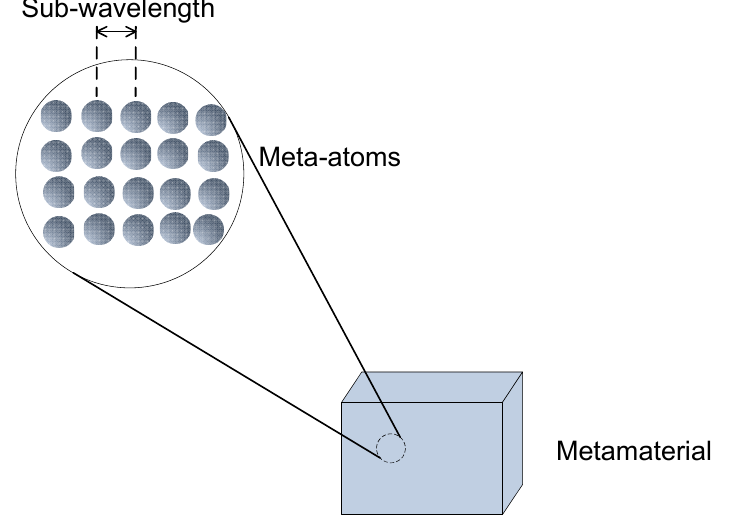
Figure 1. From meta-atoms to